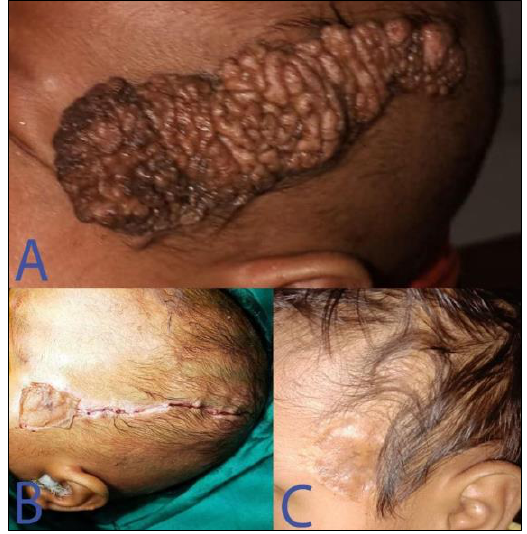
Figure 1: (A) Preoperative image showing cerebriform lesion (B) Peroperative image (C) Follow-up at 2 years showing a healed wound with acceptable